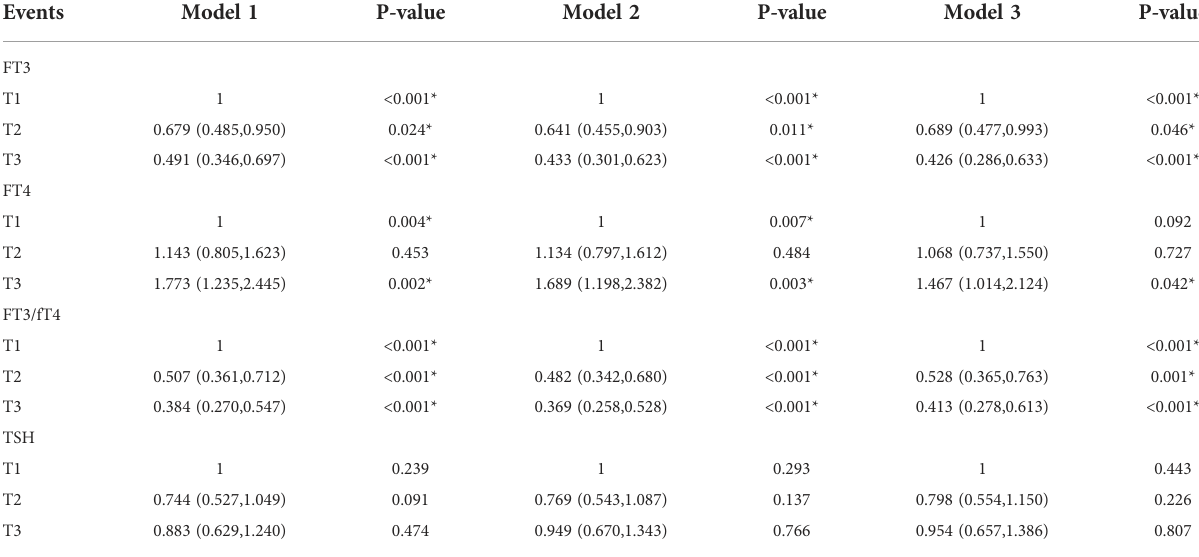
TABLE 3 Adjusted OR and 95% CI in tertiles of thyroid-related hormones in the DPN